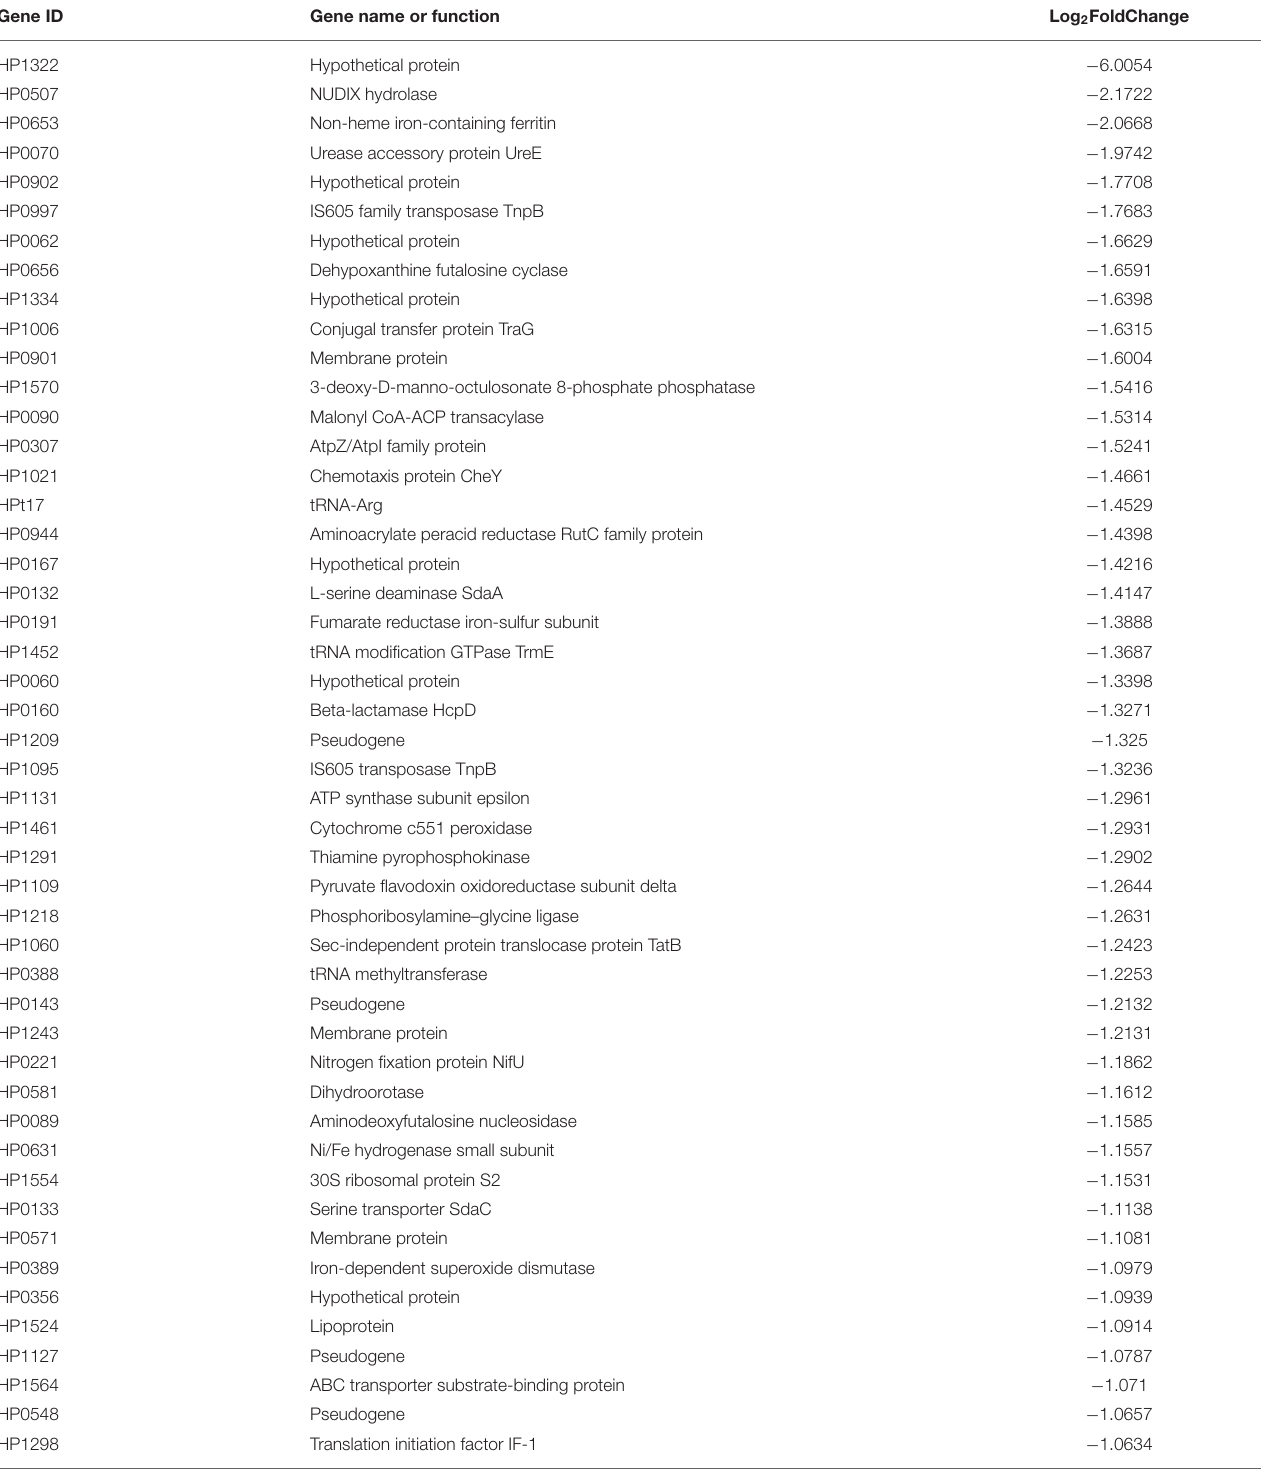
TABLE 1 | Differentially expressed genes (DEGs) characterized by RNA-sequencing (Wild type/ 1 luxS